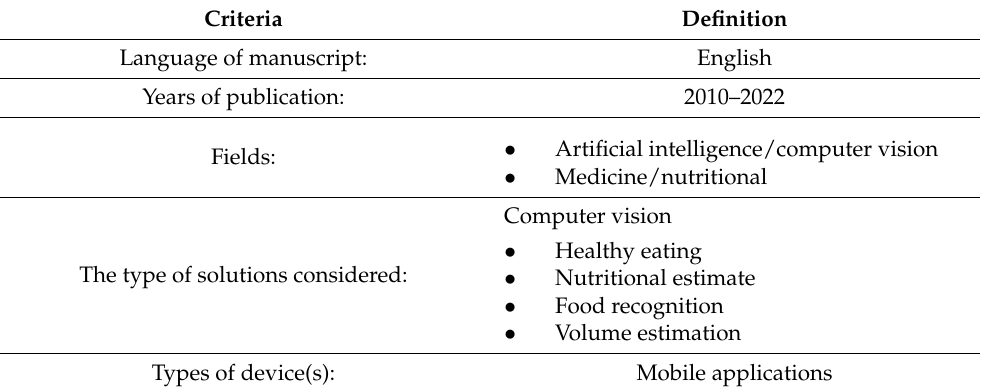
Table 1. Summary of the inclusion criteria.